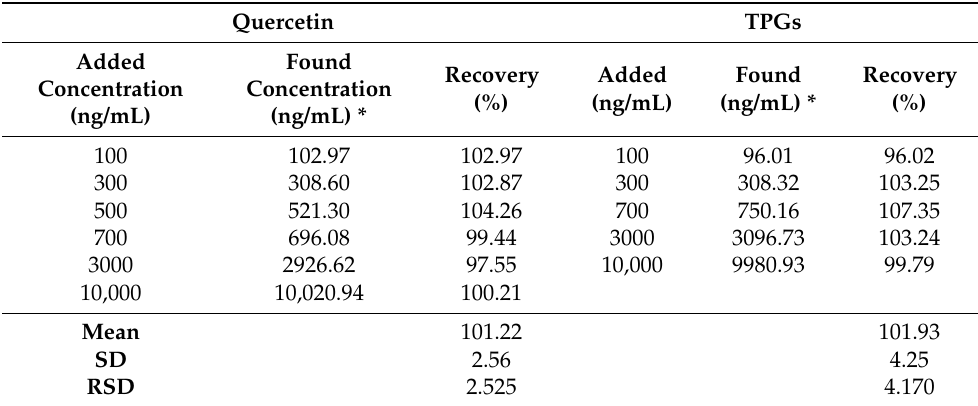
Table 3. Assay results for the determination of the studied analytes in spiked rat plasma.